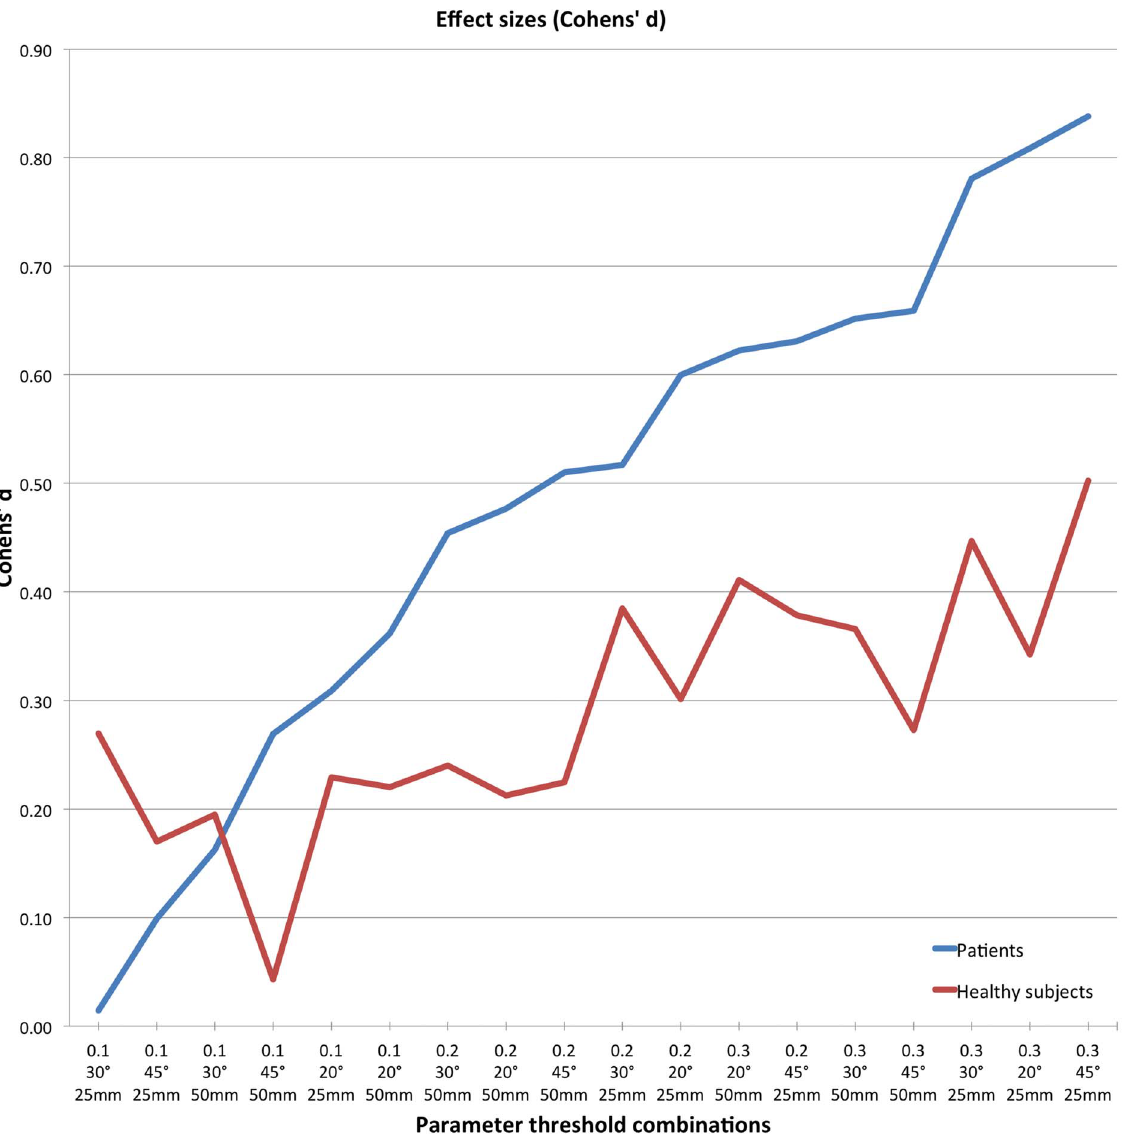
Figure 3. Effect sizes of parameter threshold combinations. The plot shows the effect size of each tested parameter threshold combination utilizing Cohens’ d. The data were sorted by the effect sizes of the patient group.